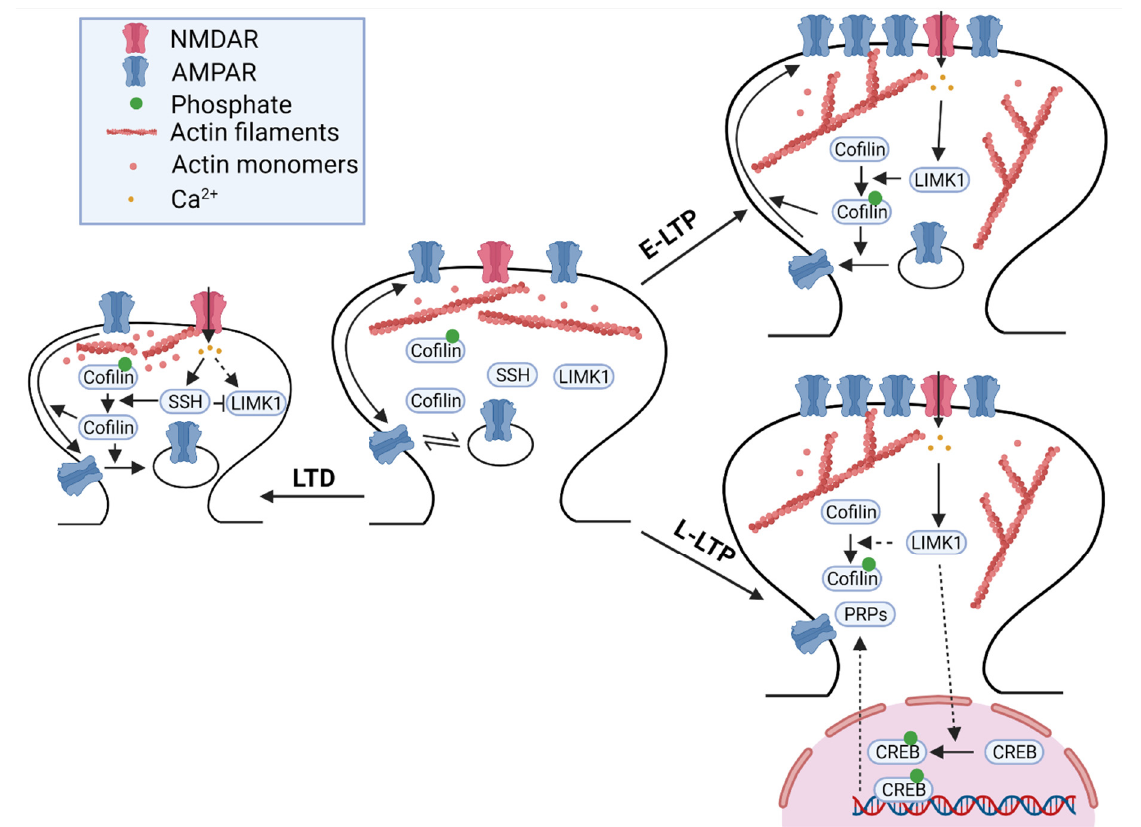
Figure 1. LIMK1 in synaptic plasticity. During LTD, the activation of NMDARs and influx of Ca 2+ activates SSH. Activated SSH dephosphorylates and inactivates LIMK1. In addition, SSH dephosphorylates and activates cofilin, which mediates actin depolymerization. This results in dendritic spine shrinkage, internalization, and lateral movement of AMPARs out of the synapse. During E-LTP, NMDAR activation and Ca 2+ influx activates LIMK1. Activated LIMK1 phosphorylates and inactivates cofilin, which subsequently leads to actin polymerization. Actin polymerization results in dendritic spine enlargement, insertion, and lateral movement of AMPARs into the synapse. During L-LTP, LIMK1 phosphorylates and activates CREB in the nucleus. The activation of CREB activates the transcription and the translation of plasticity-related proteins (PRPs) which help to maintain synaptic changes, including dendritic spine enlargement and AMPAR distribution.